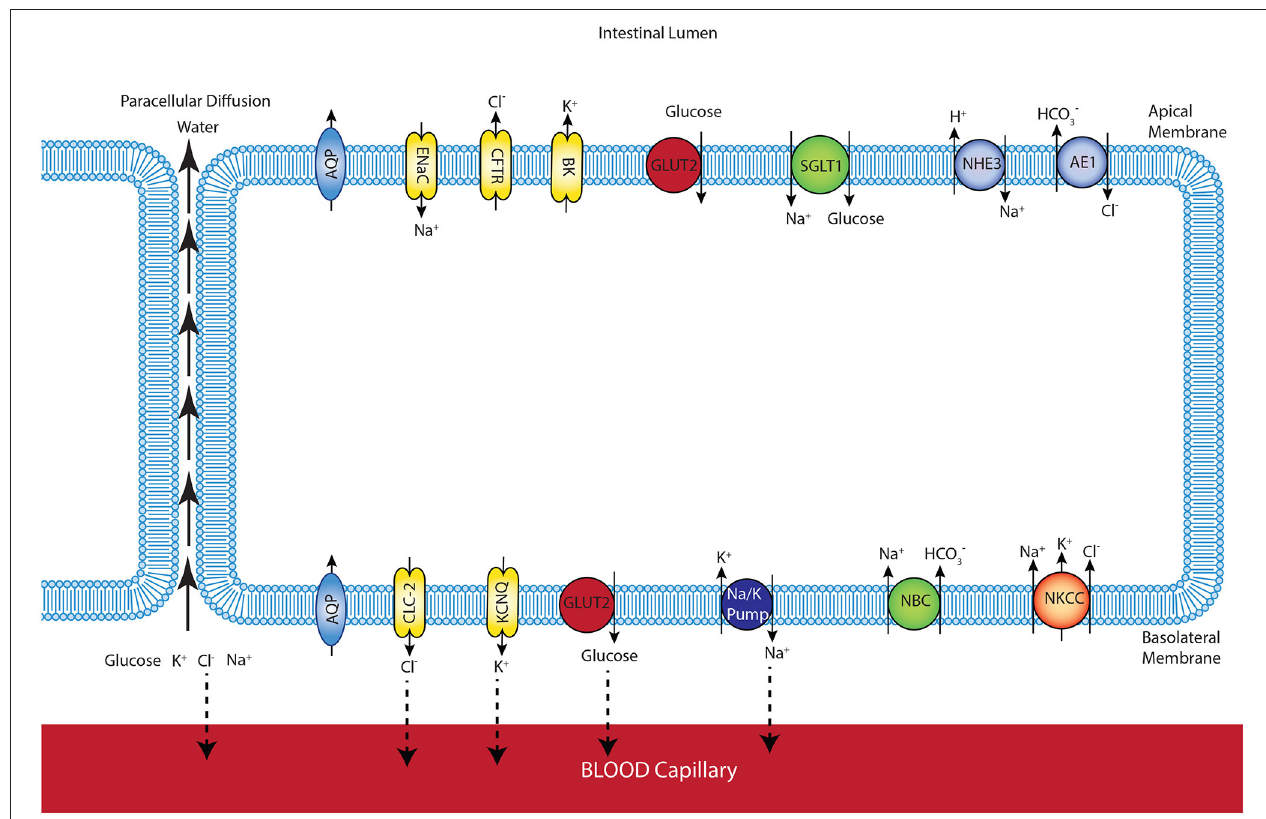
FIGURE 1 | Schematic representation of enterocyte showing the transporters relevant to glucose transport in the apical and basolateral membranes along with the apical (lumen) and basolateral (interstitium) extracellular domains.